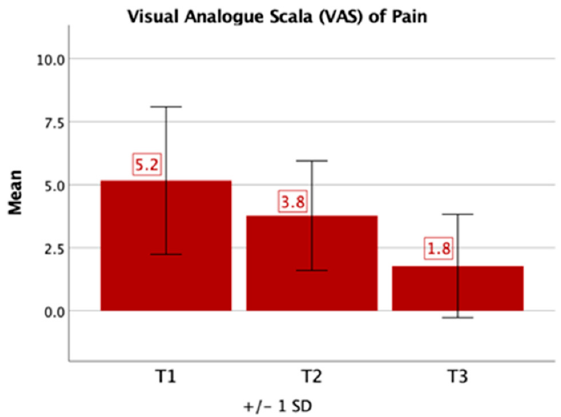
Figure 3. Time course visual analogue scale (VAS) of pain. Patients overall reported an improvement of pain symptoms during the course of the disease. SD: standard deviation.